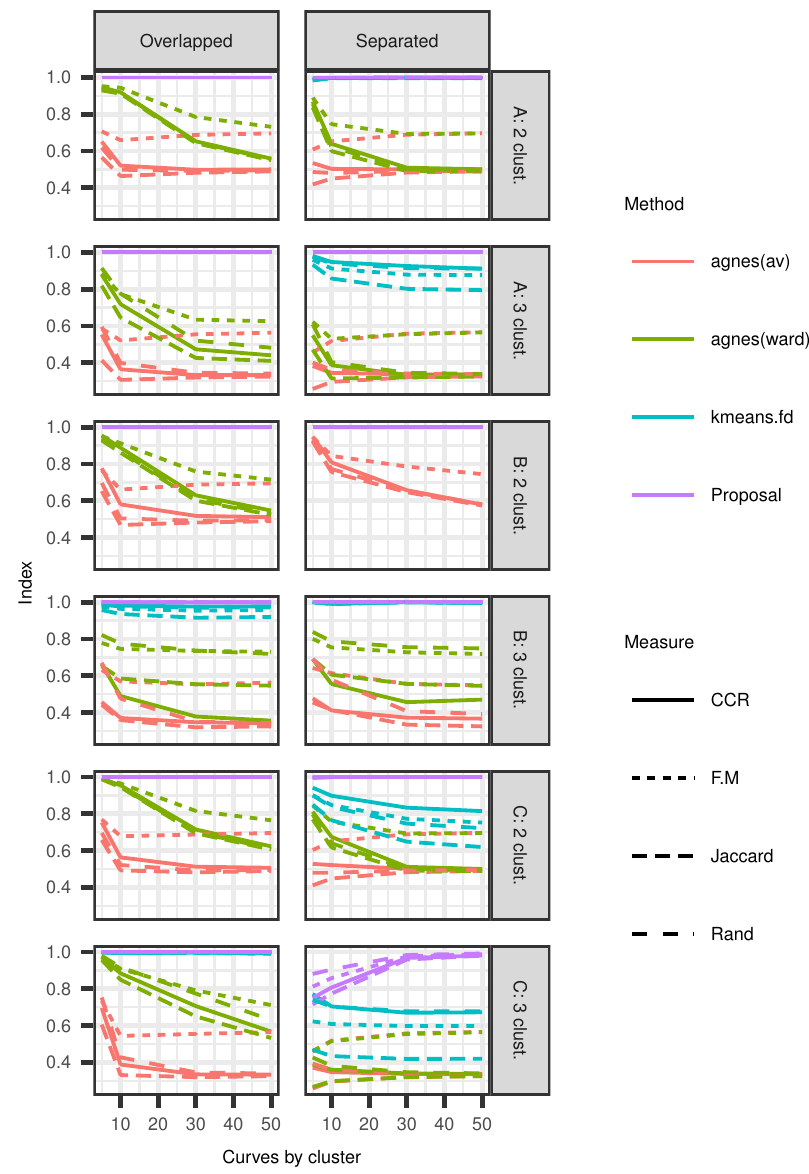
Figure 5. Performance indexes when two and three clusters of overlapped and separated ( A ) Normal ( µ , σ 2 ) , ( B ) Gamma ( α , β ) , and ( C ) Beta ( α , β ) distributions are